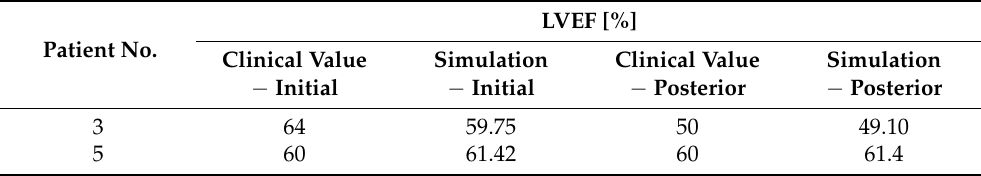
Table 2. LVEF of patients 3 and 5 in initial and posterior state compared with clinical observations. Patient